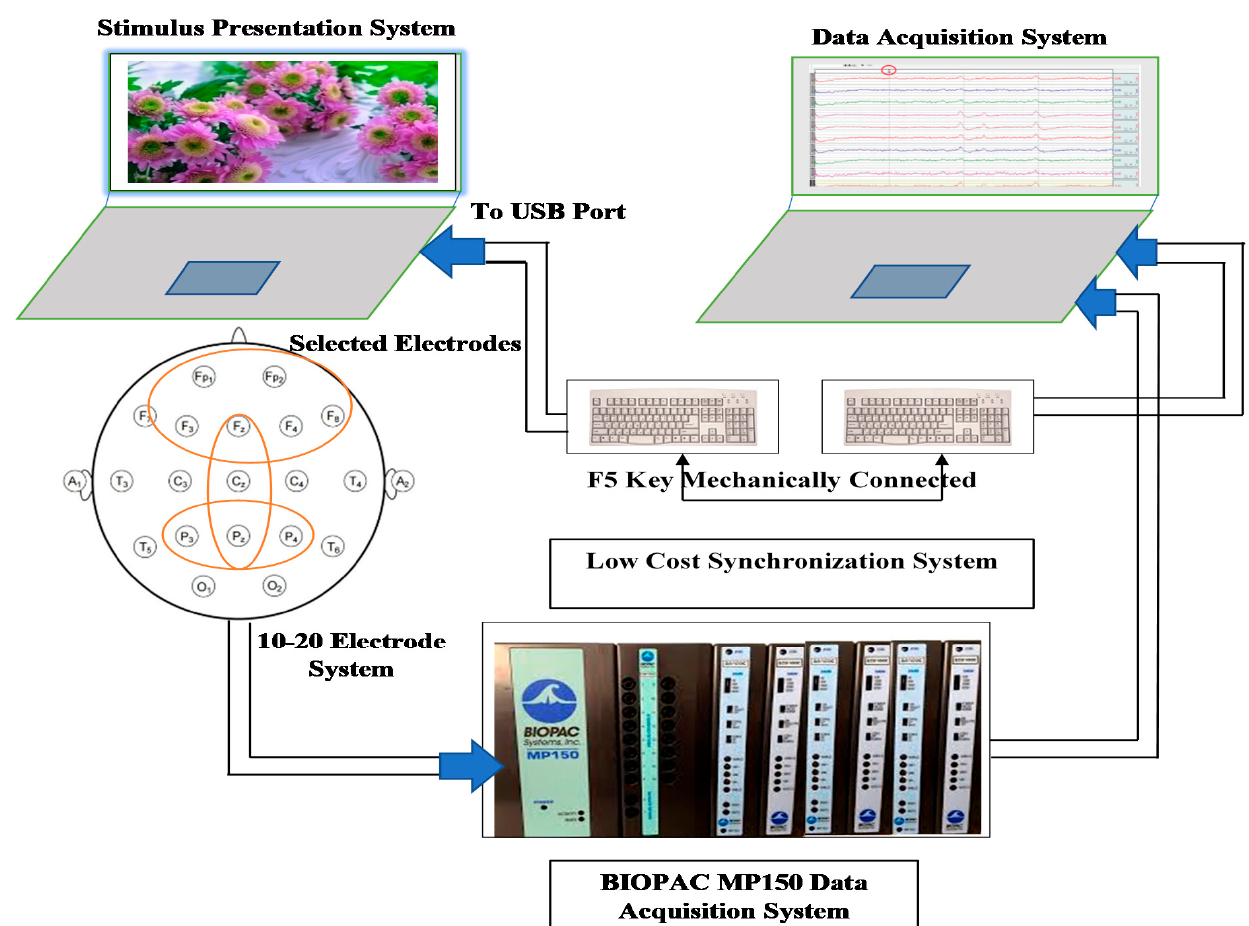
Figure 1. Data acquisition methodology used for acquiring EEG signals.